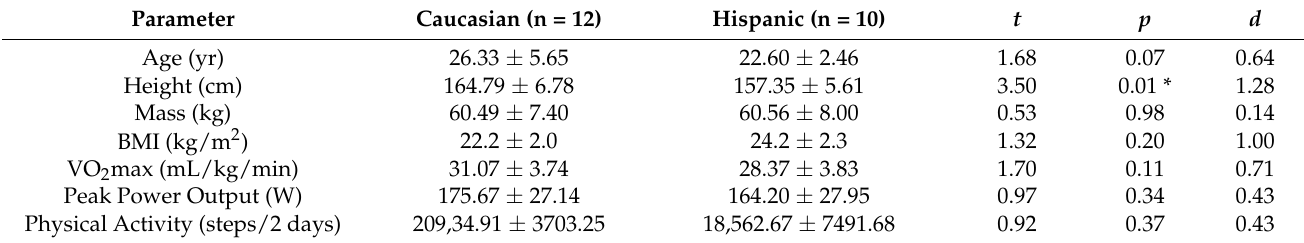
Table 1. Participant physical characteristics (mean ± SD).